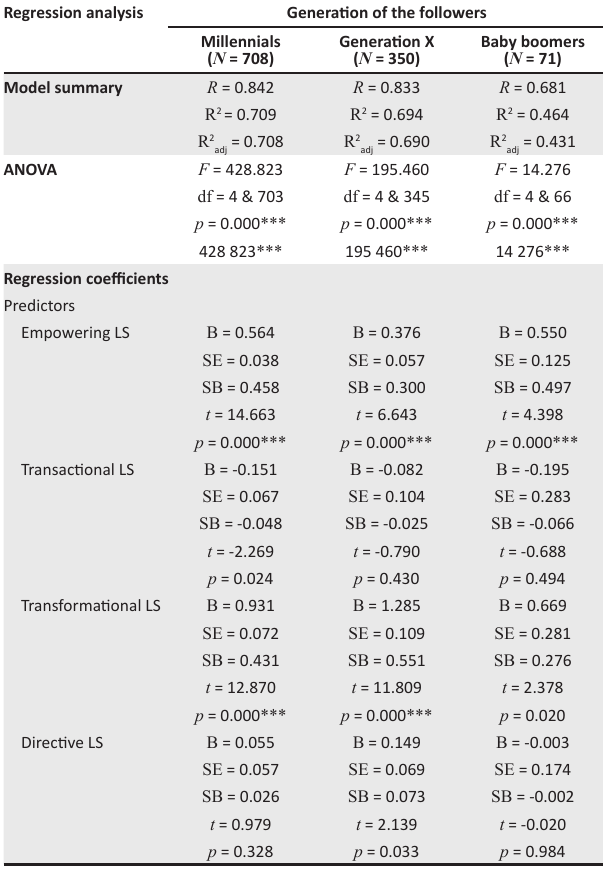
TABLE 5: Reliability data ( N = 1131). Leadership styles and effectiveness